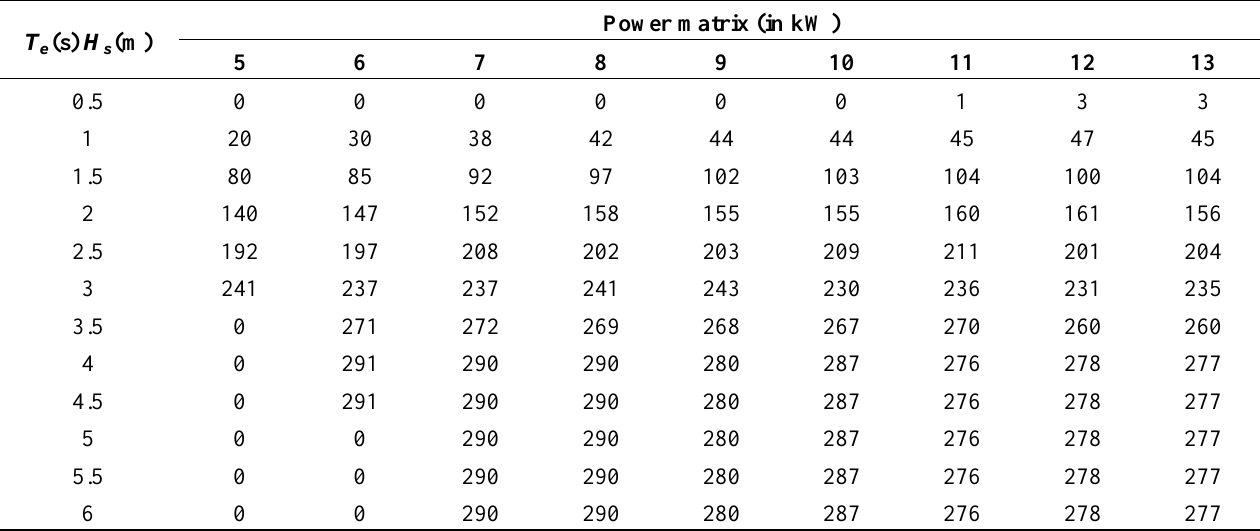
Table A3. Power matrix (in kW) for the wave energy converter Oyster.